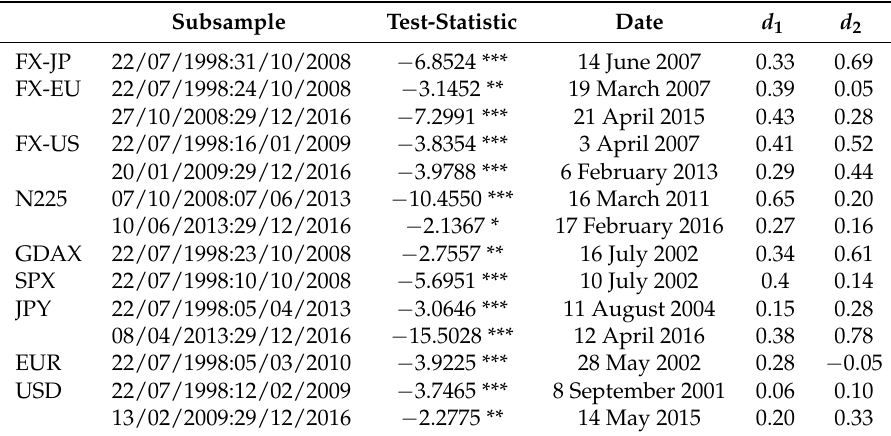
Table 12. Persistence change test in